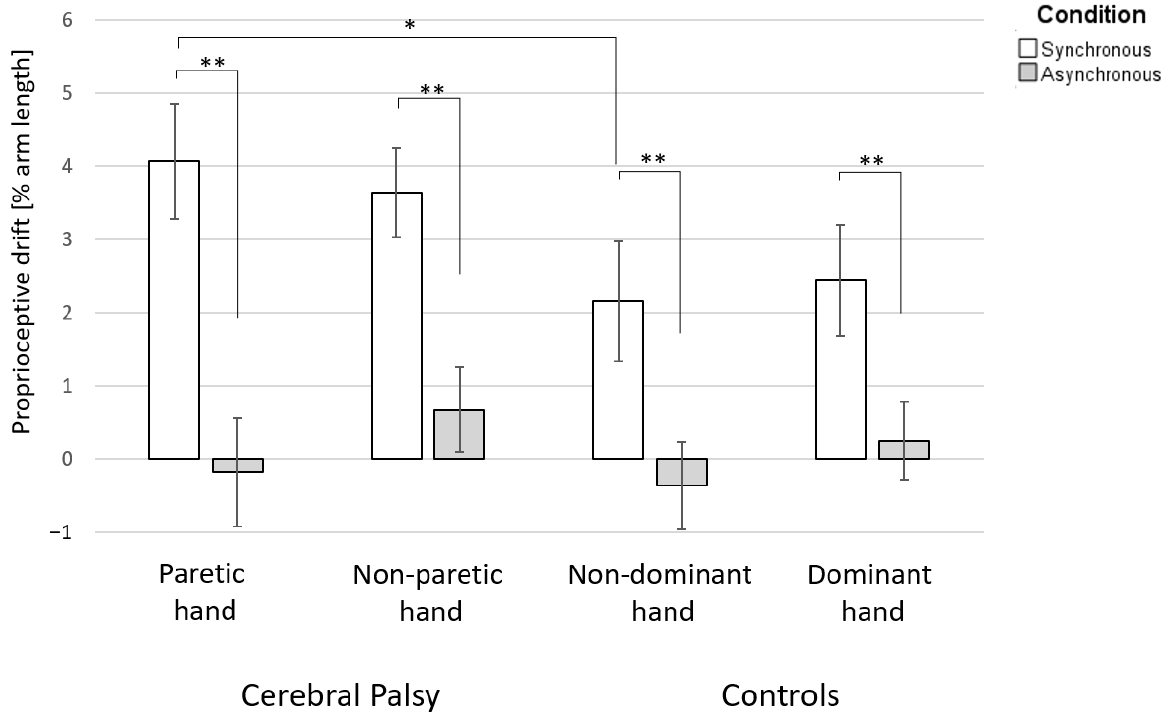
Figure 2. Proprioceptive drift in teenagers with unilateral cerebral palsy and typically developing teenagers. A positive value of proprioceptive drift indicates a drift of the felt index finger location towards the rubber hand, while a negative value shows a drift away from the rubber hand. Significant differences are indicated as follows: * p < 0.05, and ** p < 0.01.